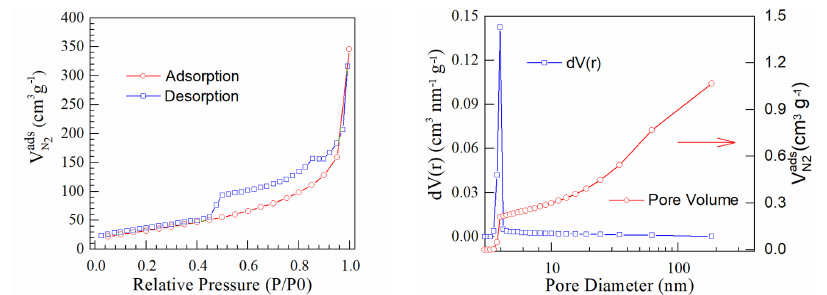
Materials 2023 , 16 , 1897